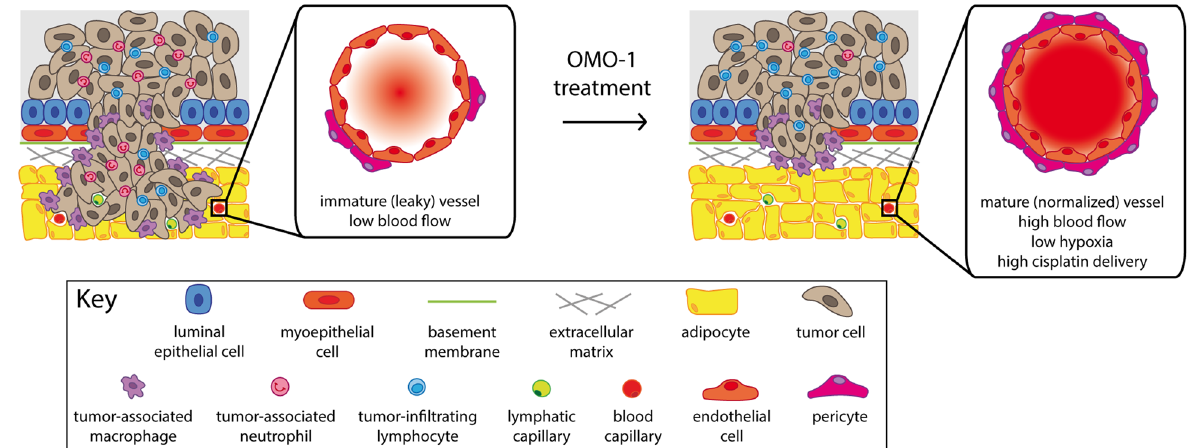
Fig. 6 Working model for OMO-1 treatment in a 4T1-based intraductal model. Key fi ndings upon treatment with OMO-1 are highlighted. More speci fi cally, tumor growth is reduced, neutrophil in fl ux is impaired (decreased MIP-2 levels and Ly6G positivity), and antitumor responses are more pronounced (increased levels of immunostimulatory and tumor suppressive proteins, decreased CD163 positivity). Leaky vessels are normalized to enhance the blood fl ow to the primary tumor (increased α -SMA, PDGFR- β , and Ang-1 positivity as well as enhanced α -SMA- covered CD31 + vessels), which in turn reduces tumor hypoxia and increases the delivery of chemotherapeutics (increased cisplatin DNA- adducts and cleaved caspase 3